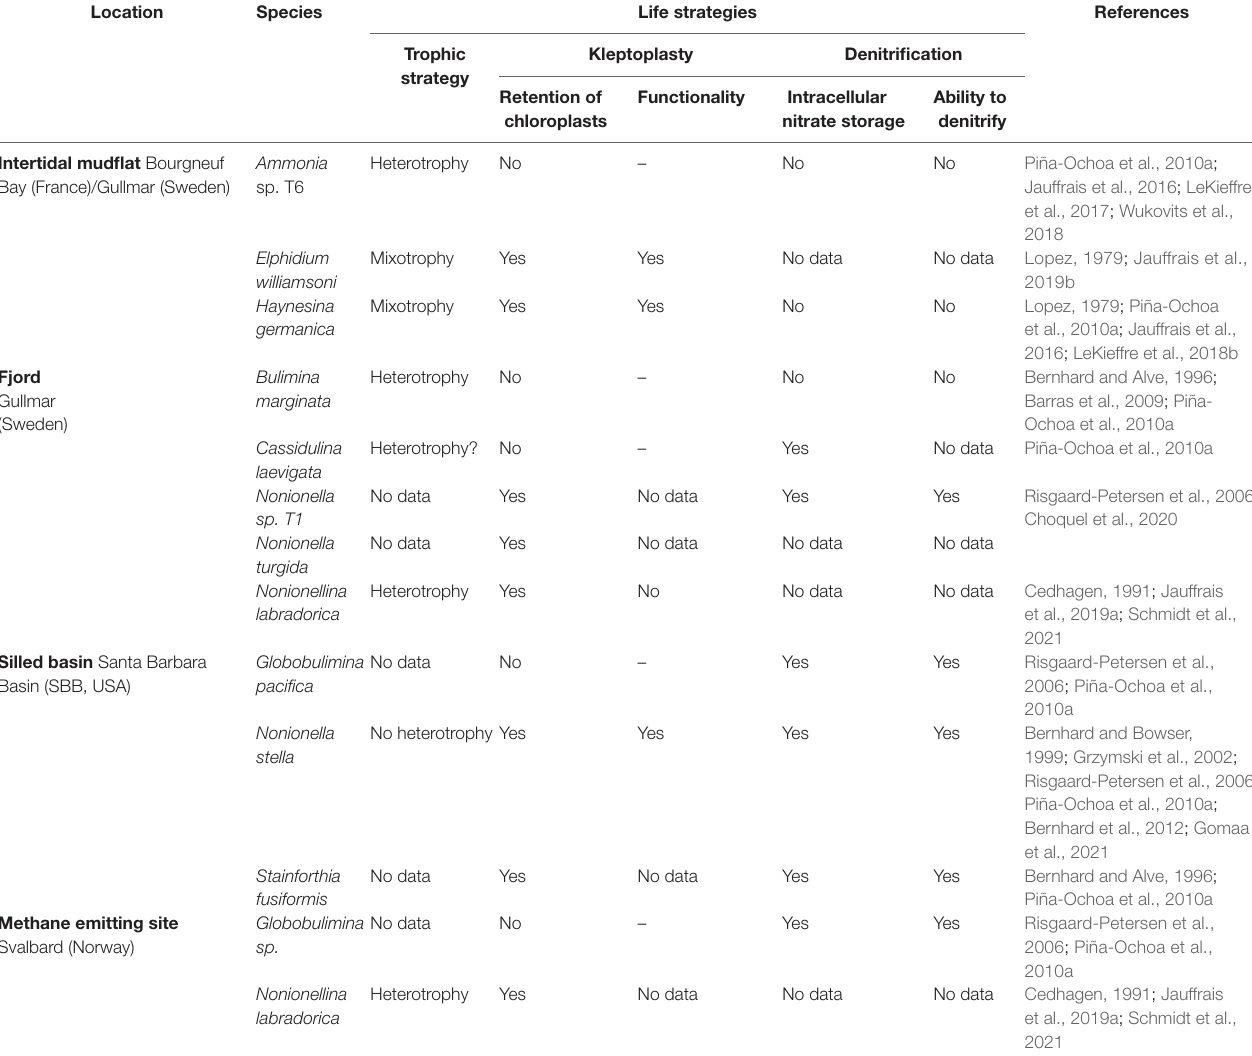
TABLE 1| Species investigated in this study from four different marine environments, with indications of key life strategies per prior publications (perhaps from different locales).